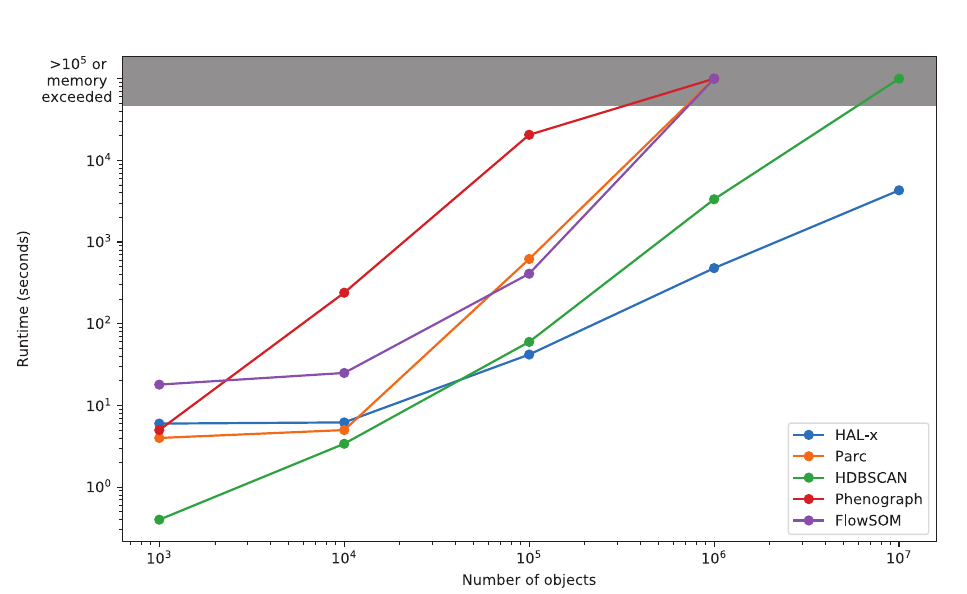
Fig 5. Comparison of run times for training and label prediction on synthetic datasets of increasing sizes (comparing HAL-X with other clustering algorithms routinely used with cytometry data -Parc, FlowSOM, HDBScan & Phenograph). The graybox indicates that the memory of laptop was exceeded for large datasets when using other algorithms than HAL-X.